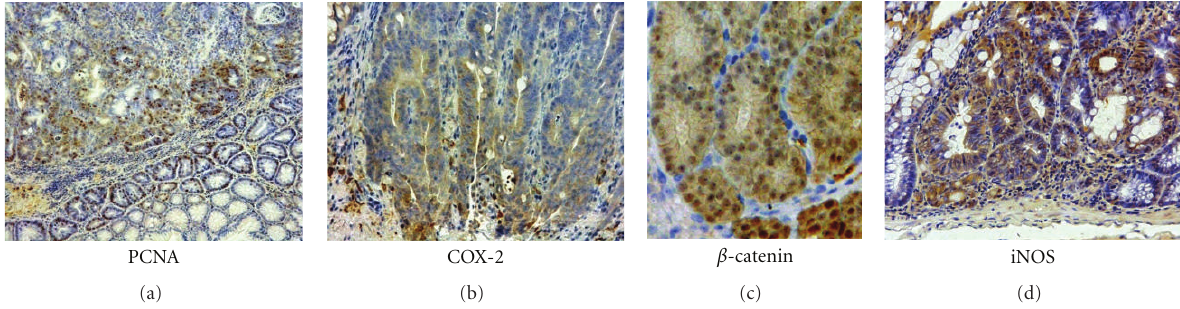
Figure 14: Immunohistochemistry of PCNA, β -catenin, COX-2, and iNOS in colonic adenocarcinomas of mice induced by AOM and DSS.